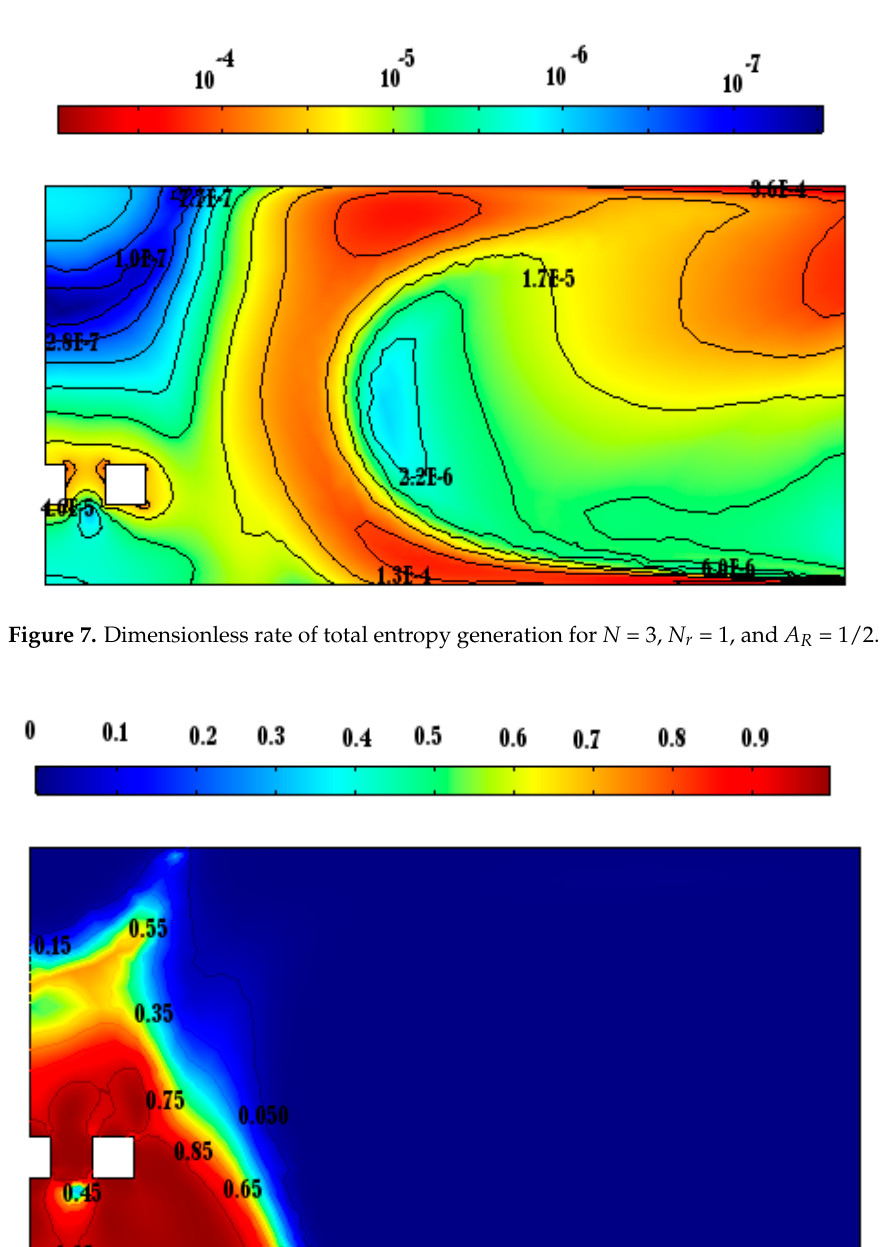
Figure 8. Bejan number for N = 3, N r = 1, and A R = 1/2.